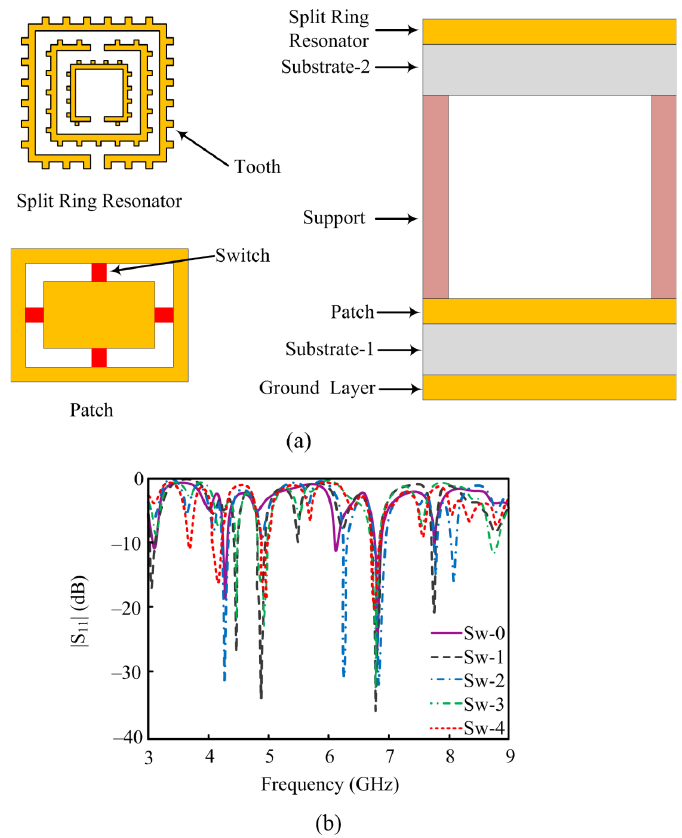
Figure 13. The SRR loaded reconfigurable antenna ( a ) geometrical configuration ( b ) |S 11 | results (adapted from [143]).